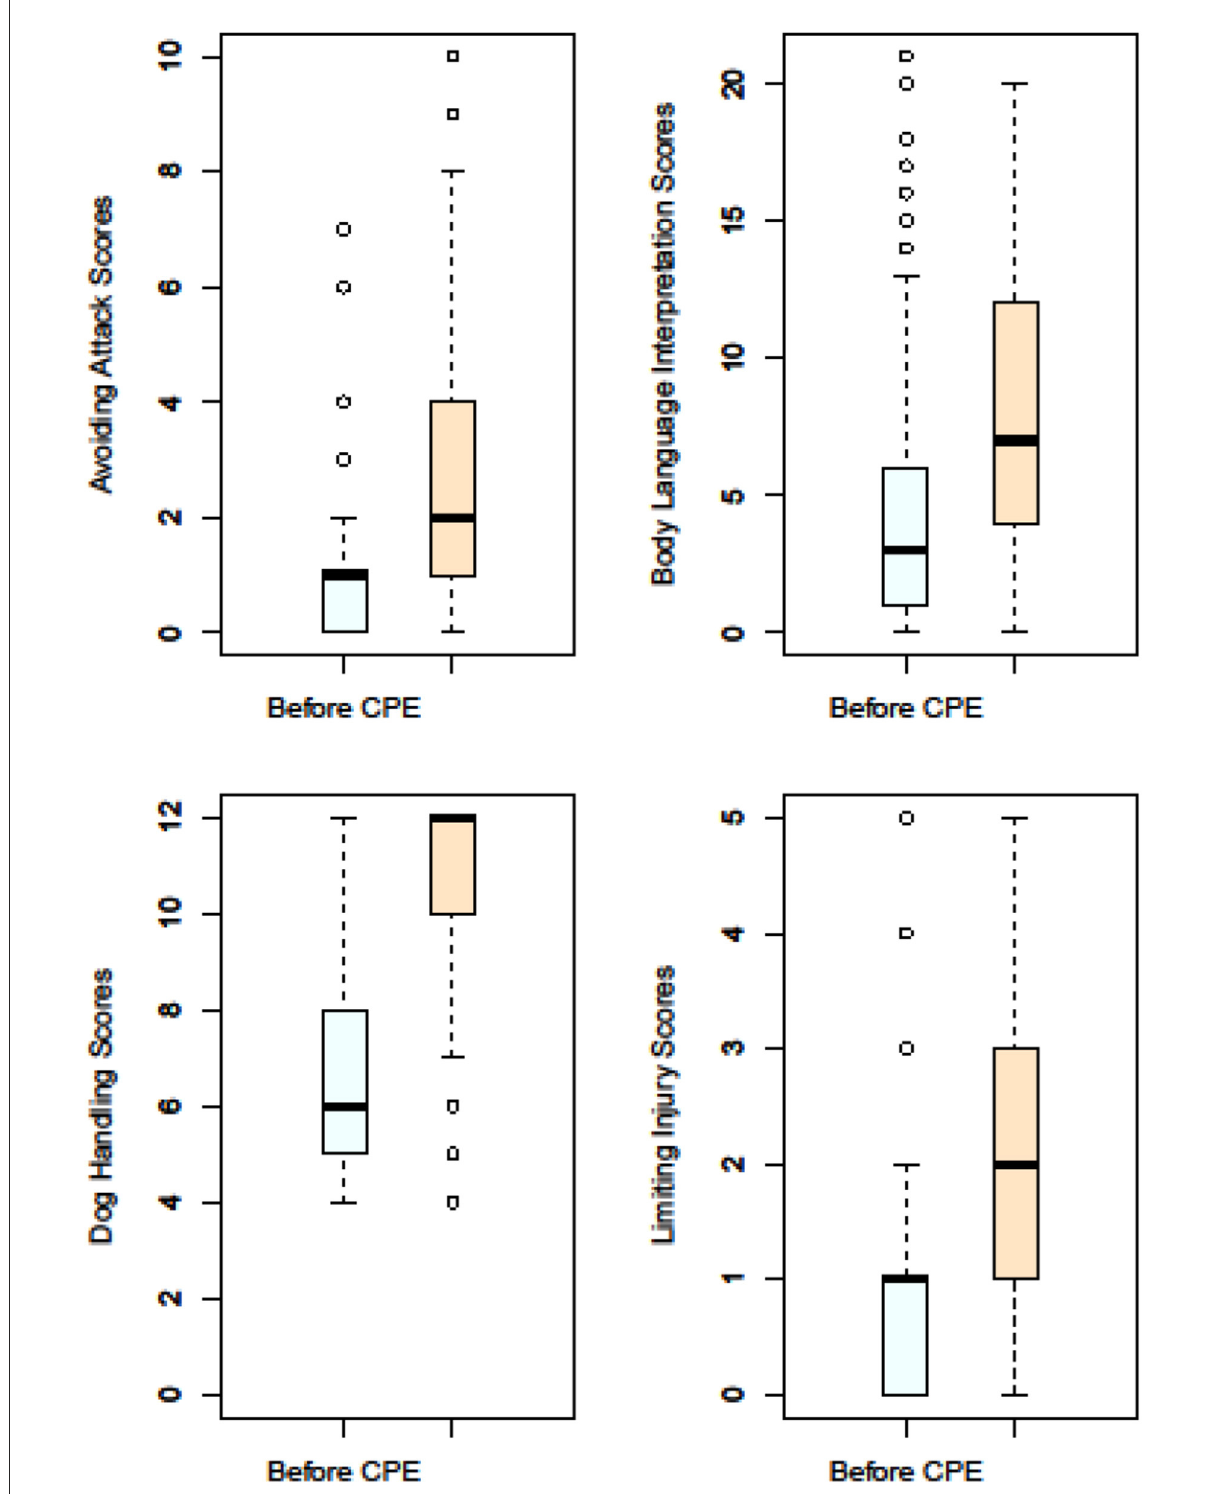
FIGURE2 Scores on dog body language interpretation, ways of avoiding dog attacks, ways of limiting injury when attacked and dog handling, before and after engagement